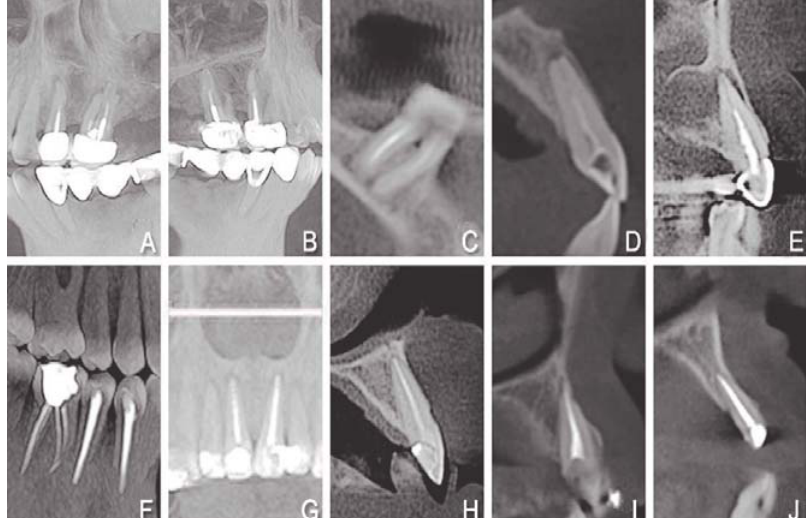
Figure 1- (cid:3)(cid:36)(cid:16)(cid:40)(cid:12)(cid:3)(cid:44)(cid:81)(cid:86)(cid:88)(cid:73)(cid:191)(cid:70)(cid:76)(cid:72)(cid:81)(cid:87)(cid:3)(cid:11)(cid:88)(cid:81)(cid:71)(cid:72)(cid:85)(cid:191)(cid:79)(cid:79)(cid:72)(cid:71)(cid:12)(cid:3)(cid:85)(cid:82)(cid:82)(cid:87)(cid:3)(cid:70)(cid:68)(cid:81)(cid:68)(cid:79)(cid:3)(cid:191)(cid:79)(cid:79)(cid:76)(cid:81)(cid:74)(cid:30)(cid:3)(cid:37)(cid:12)(cid:3)(cid:88)(cid:81)(cid:71)(cid:72)(cid:87)(cid:72)(cid:70)(cid:87)(cid:72)(cid:71)(cid:3)(cid:70)(cid:68)(cid:81)(cid:68)(cid:79)(cid:86)(cid:30)(cid:3)(cid:38)(cid:15)(cid:42)(cid:12)(cid:3)(cid:36)(cid:83)(cid:76)(cid:70)(cid:68)(cid:79)(cid:3)(cid:79)(cid:72)(cid:86)(cid:76)(cid:82)(cid:81)(cid:30)(cid:3)(cid:41)(cid:12)(cid:3)(cid:50)(cid:89)(cid:72)(cid:85)(cid:191)(cid:79)(cid:79)(cid:72)(cid:71)(cid:3)(cid:85)(cid:82)(cid:82)(cid:87)(cid:3)(cid:191)(cid:79)(cid:79)(cid:76)(cid:81)(cid:74)(cid:3) (cid:68)(cid:81)(cid:71)(cid:3)(cid:76)(cid:81)(cid:86)(cid:87)(cid:85)(cid:88)(cid:80)(cid:72)(cid:81)(cid:87)(cid:3)(cid:73)(cid:85)(cid:68)(cid:70)(cid:87)(cid:88)(cid:85)(cid:72)(cid:3)(cid:44)(cid:12)(cid:30)(cid:3)(cid:36)(cid:83)(cid:76)(cid:70)(cid:68)(cid:79)(cid:3)(cid:85)(cid:72)(cid:86)(cid:82)(cid:85)(cid:83)(cid:87)(cid:76)(cid:82)(cid:81)(cid:3)(cid:43)(cid:15)(cid:45)(cid:12)(cid:30)(cid:3)(cid:54)(cid:88)(cid:73)(cid:191)(cid:70)(cid:76)(cid:72)(cid:81)(cid:87)(cid:3)(cid:85)(cid:82)(cid:82)(cid:87)(cid:3)(cid:191)(cid:79)(cid:79)(cid:76)(cid:81)(cid:74)